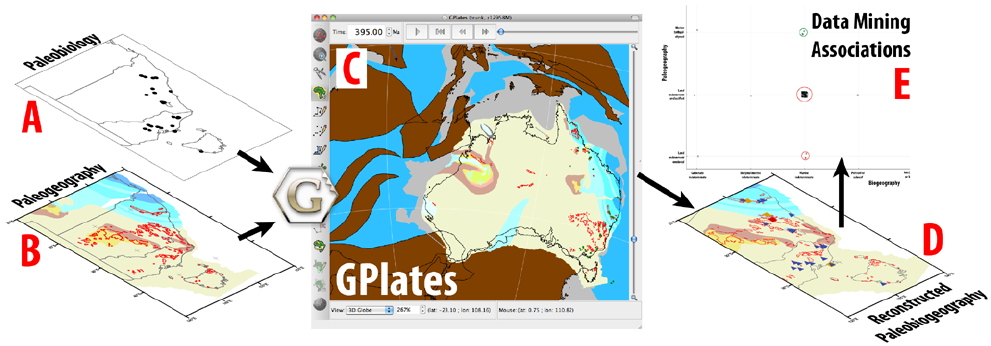
Fig. 3. Fossil collections (a) and the Australian paleogeography (b) are reconstructed in GPlates (c) using a Phanerozoic plate motion model, from which reconstructed paleogeographies (d) and data associations (e) are derived in order to test and refine the paleogeographic and plate motion